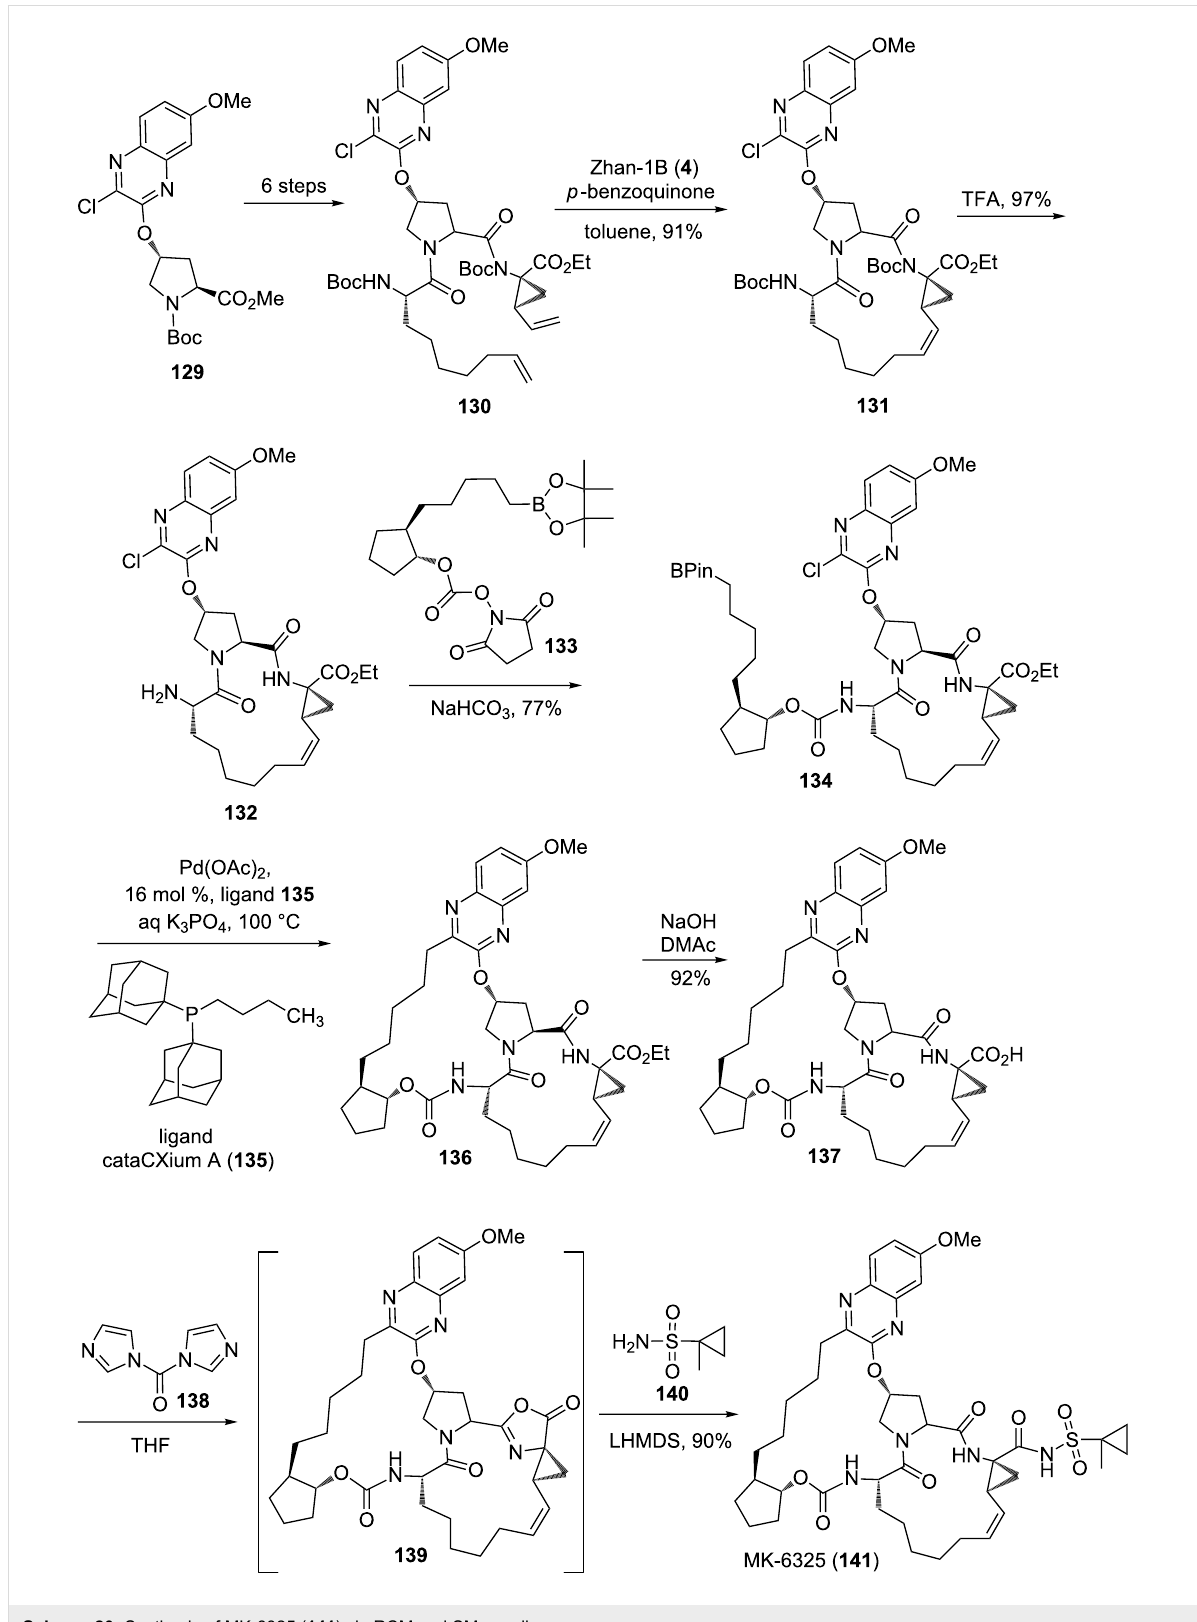
Scheme 20: Synthesis of MK-6325 ( 141 ) via RCM and SM